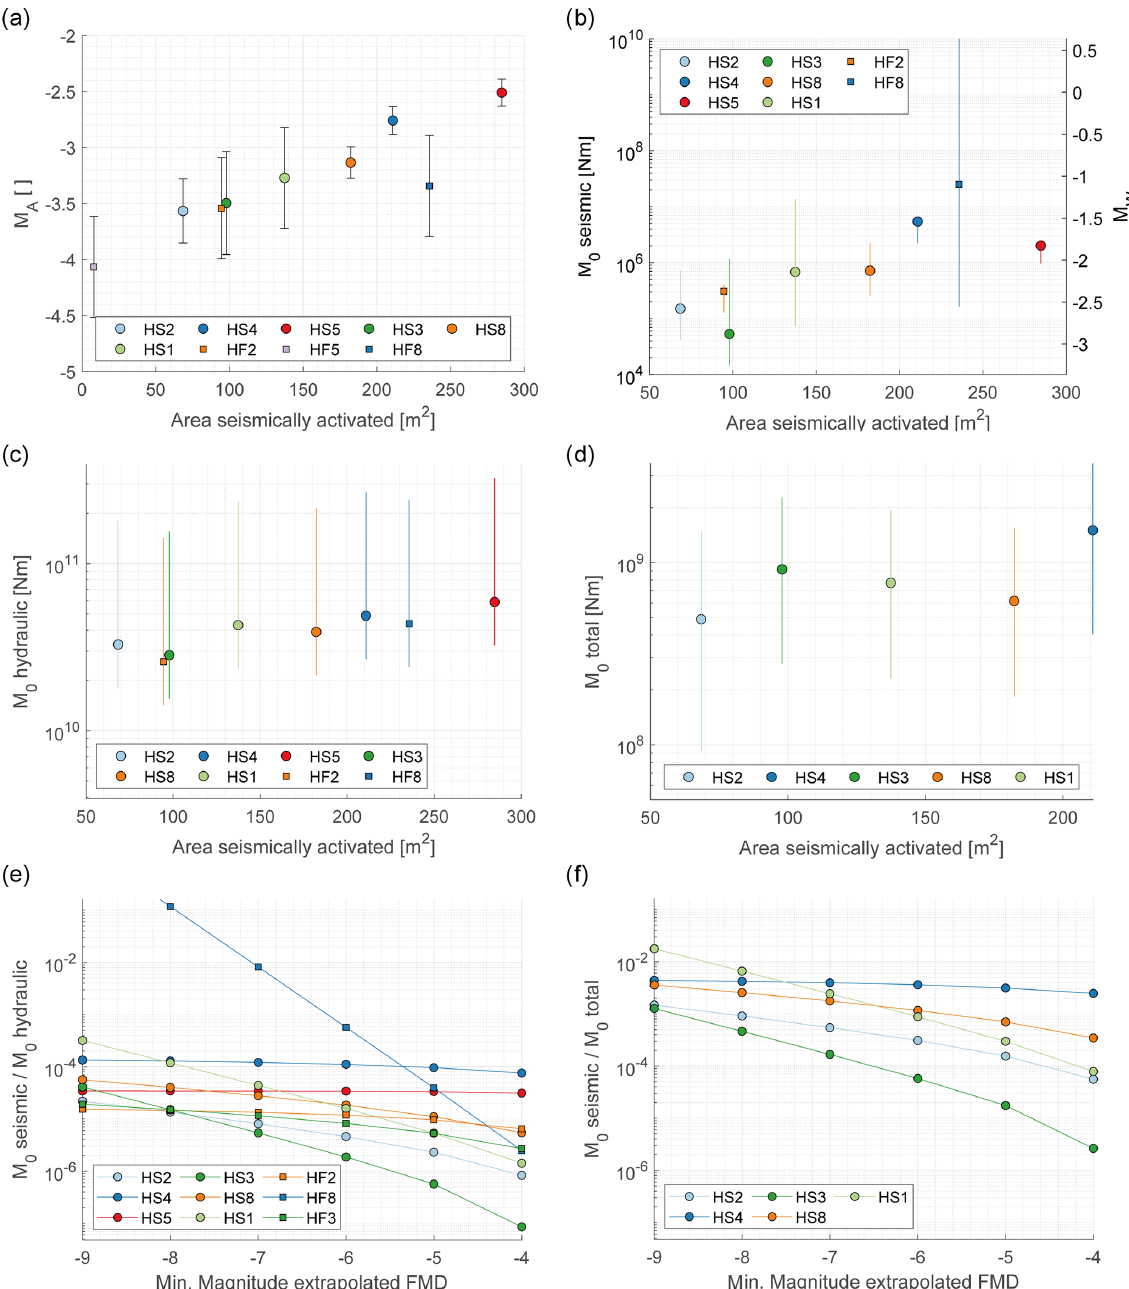
Figure 12. (a) Maximum observed magnitudes (error bars represent the standard deviation of all magnitude estimates of the respective event) with respect to seismically activated area (the estimated seismically activated area represents the mean between the upper and lower bound of the area estimate of Sect. 4.2). (b) Estimated radiated seismic moment from extrapolated Gutenberg–Richter parameter (upper-bound and average estimate) and located seismic events (lower bound) along with the equivalent moment magnitude. (c) Equivalent hydraulic moment estimated from injection parameter (i.e., flow rate, injection pressure). (d) Equivalent moment estimate from acoustic televiewer displacement measurements at the injection interval. (e) Seismic injection efficiency against the magnitude level used for seismic moment extrapolation. (f) Ratio between seismic moment and equivalent seismic moment estimated from displacement measurements against the magnitude level used for seismic moment